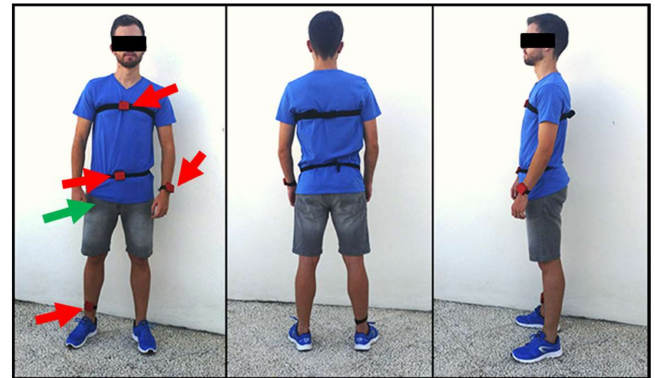
Figure 2. Example of the distribution of the sensors worn by an experimental subject. The green arrow indicates the position of the smartphone. Red arrows correspond to the SensorTag modules, which are attached to the user’s body by means of elastic